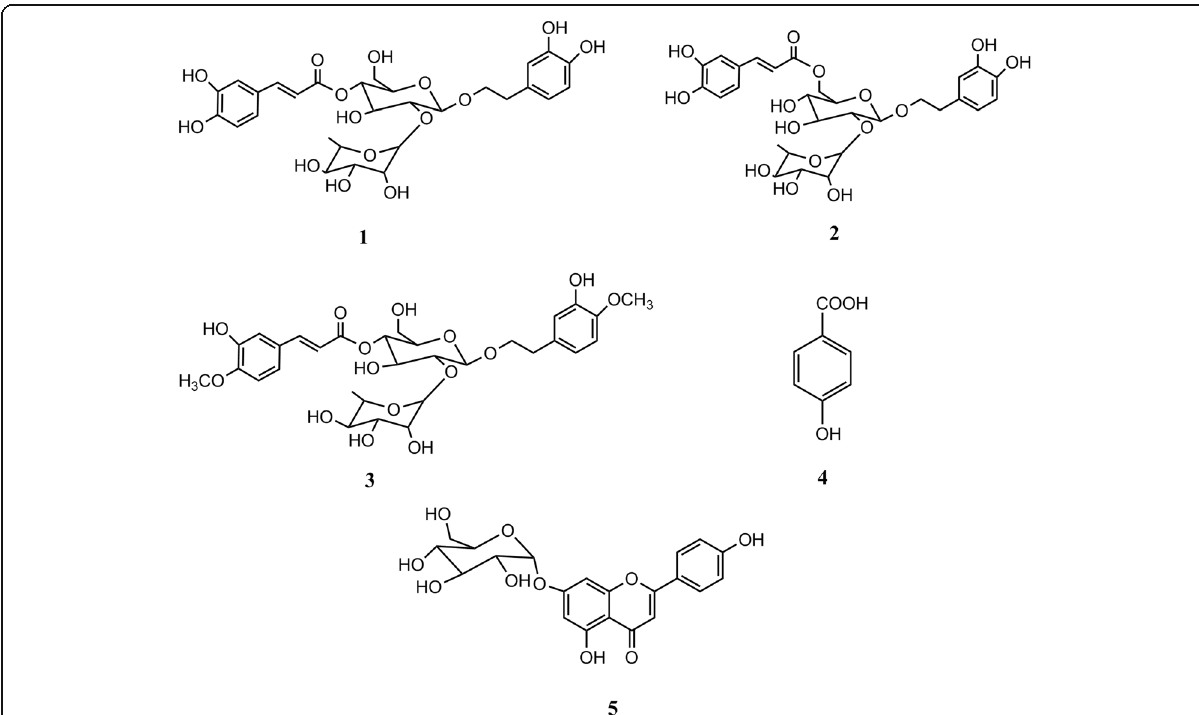
Fig. 1 Chemical structure of isolated phenolic constituents from B. cristata varalba